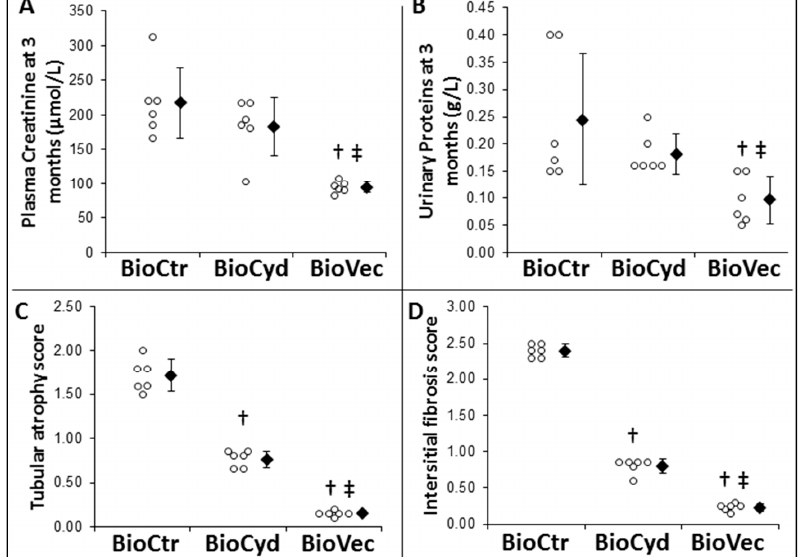
Figure 6. Evaluation of Vectisol ® benefits during static preservation: late follow-up. The benefits of supplementation were evaluated at the end of the three months’ follow-up. Biological evaluation was performed through ( A ) Plasma Creatinine and ( B ) Urinary Proteins. Histological evaluations of ( C ) Tubular Atrophy and ( D ) Intersitial Fibrosis was performed by a blinded pathologist following a semi-quantitative grading of the percentages of lesions by field: scores: 0 = no alteration, 1 = lesions < 25%, 2 = lesions between 25–50%, 3 = lesions between 51–75%, 4 = lesions between 76–100%. Shown are each data point (empty dots), as well as mean ± SD (filled diamonds), statistics (Dunn’s Test followed by Kruskal Wallis post-hoc): † : p < 0.05 to BioCtR, ‡ : p < 0.05 to